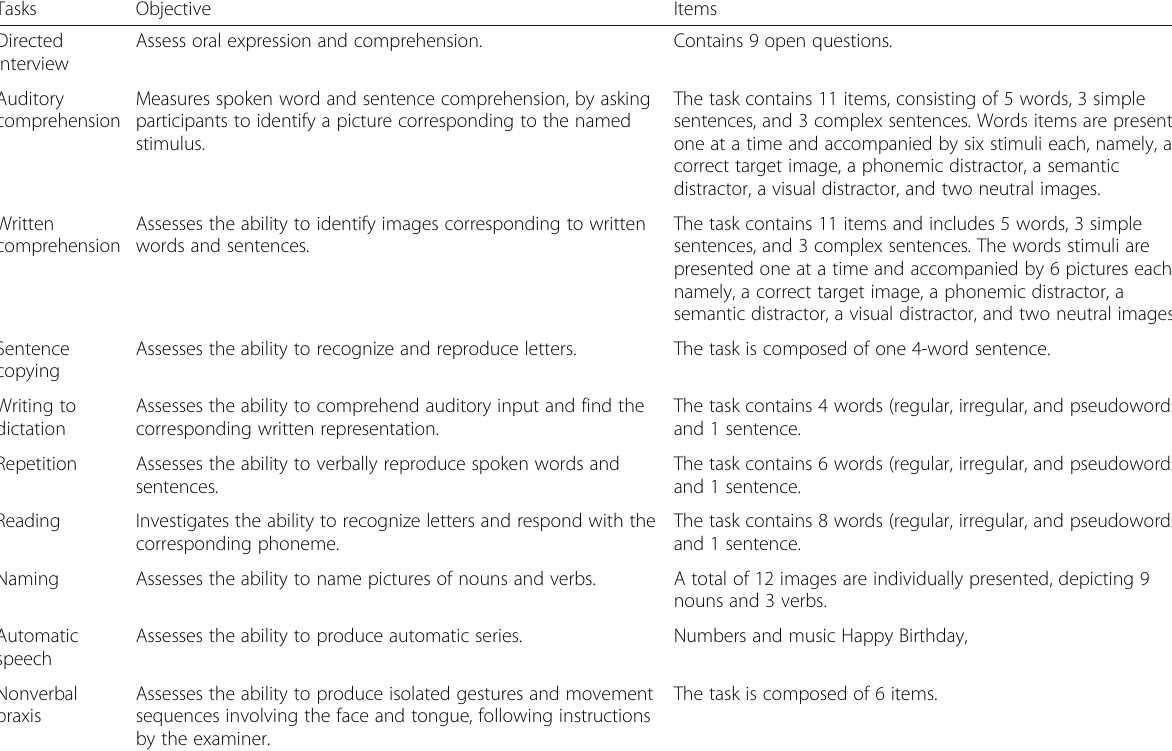
Table 2 Description of Brief MTL-BR